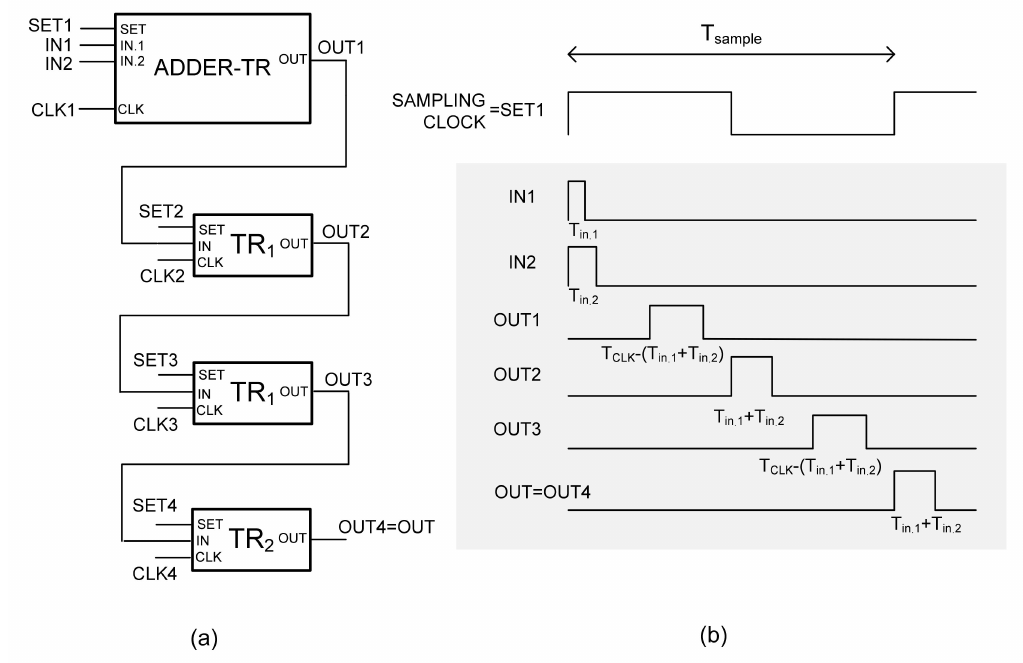
Figure 8. ( a ) Example of two inputs time-mode z − 1 adder and a ( b ) pulses timing